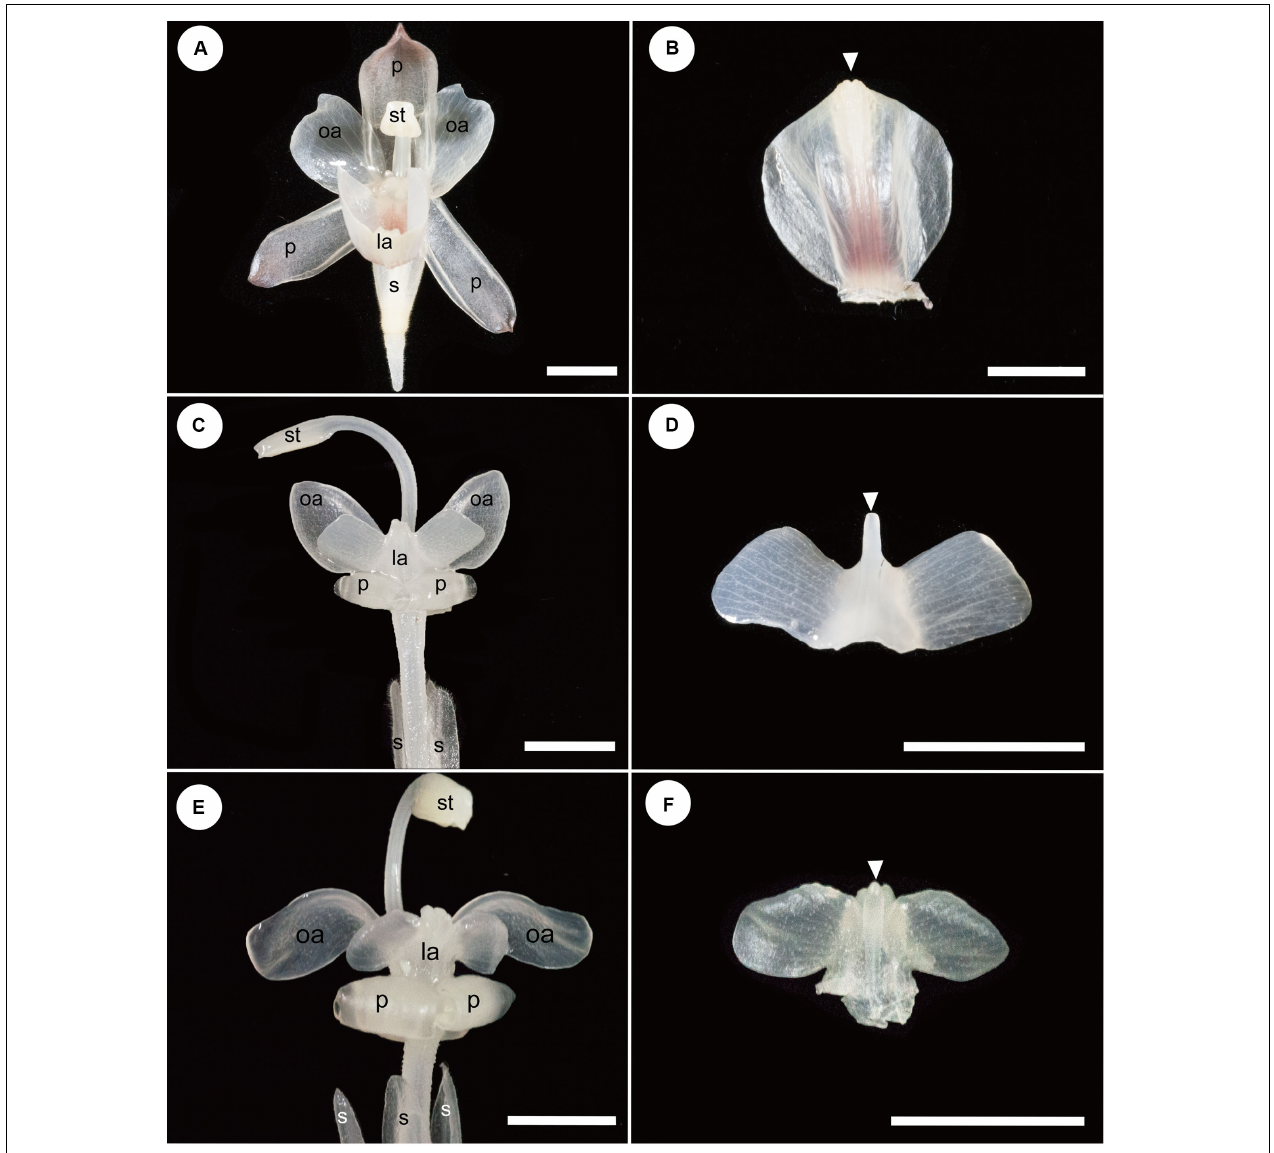
FIGURE 3 | Floral and labellum morphology of Hemiorchis and Gagnepainia. The adaxial side of the labellum is shown, and the proximal end of the labellum is at the bottom of figures in panels (B,D,F) . (A) Flower of Hemiorchis burmanica. (B) Labellum of H. burmanica , dissected from (A) . White arrowhead points to the bilobed tip of the carina. (C) Flower of Gagnepainia harmandii. (D) Labellum of G. harmandii. , dissected from (C) . White arrowhead points to the long projection of the carina. (E) Flower of G. godefroyi. (F) Labellum of G. godefroyi , dissected from (E) . White arrowhead points to the short projection of the carina. Two additional projections are formed on the abaxial side of the labellum. ca; carina of labellum; ia, inner androecial element (staminode); la, labellum; oa, outer androecial element (staminode); p, petal; s, sepal; st, stamen. Scale bars = 5 mm.